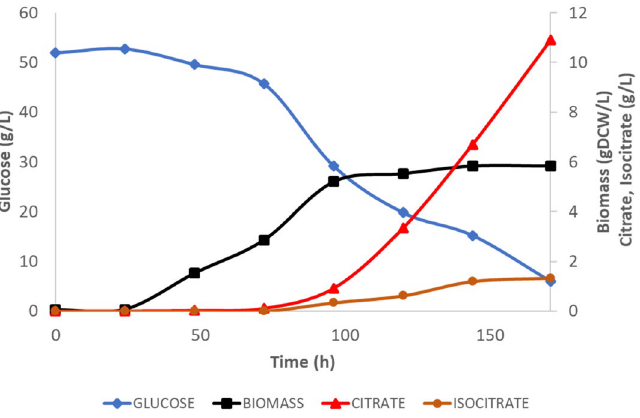
Figure 1. Experimental data obtained from batch (n = 1) of Y. lipolytica culture. Citrate and isocitrate are produced upon cultures reach stationary